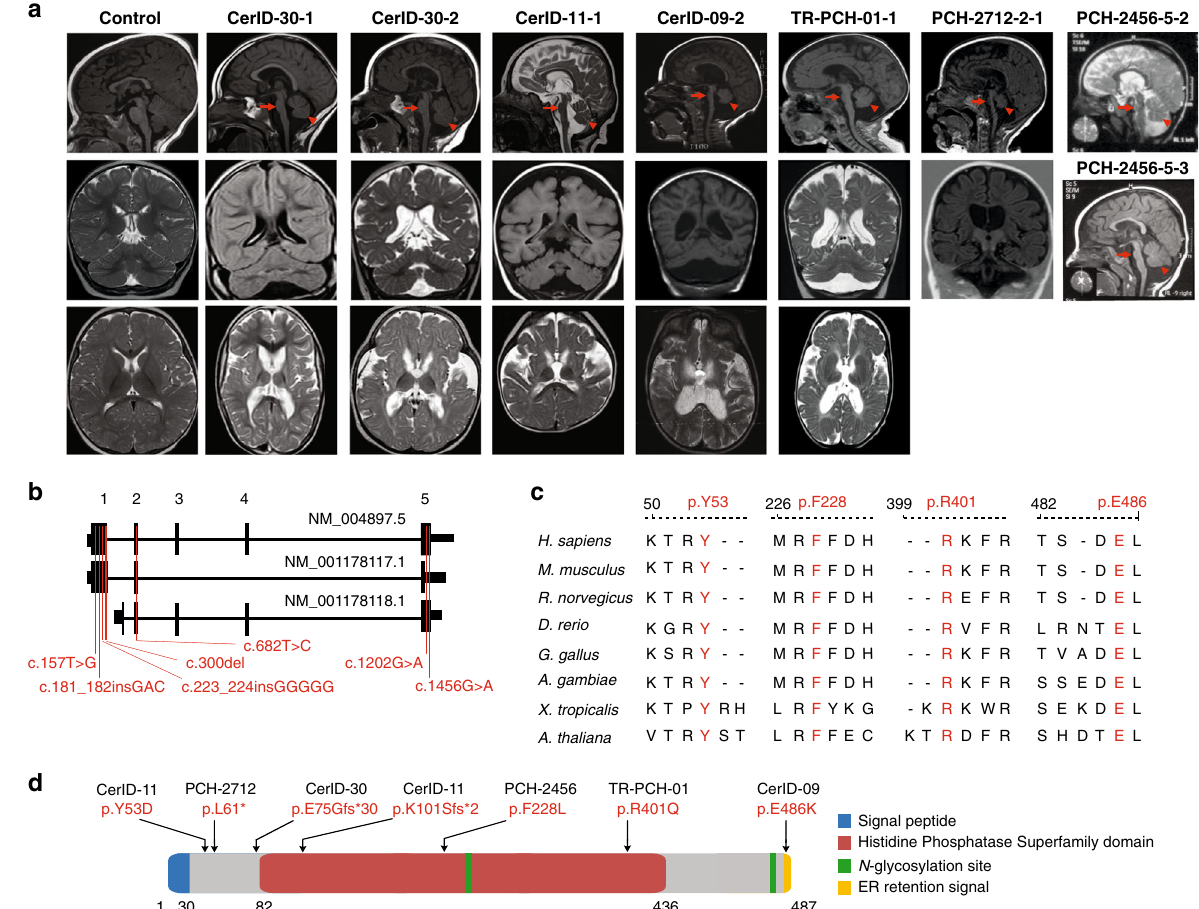
Fig. 1 Biallelic mutations in MINPP1 cause a distinct PCH phenotype. a Midline sagittal (top), coronal (middle), and axial (bottom) brain MRIs of control and patients from families CerID-30, CerID-11, CerID-09, and TR-PCH-01, respectively. Only sagittal (top) and coronal (middle) brain MRIs were available for the patient from the family PCH-2712 and sagittal brain MRI for the patients from PCH-2456 (top and middle). Sagittal MRIs show variable degree of brainstem (arrow) and cerebellar atrophy/hypoplasia (arrowhead). b Schematic representation of the MINPP1 transcripts: NM_004897.5, NM_001178117.1, and NM_001178118.1, respectively. Exon numbers for the longest isoform NM_004897.5 are indicated above the schematic representation. Mutations are shown relative to their cDNA (NM_004897.5) position. c Multiple-sequence alignment of MINPP1 from different species. Variant amino-acid residues p.Y53, p.F228, p.R401, and p.E486 are evolutionarily conserved. d Linear schematic representation of MINPP1, showing the position of mutations with respect to predicted protein domains. Endoplasmic reticulum